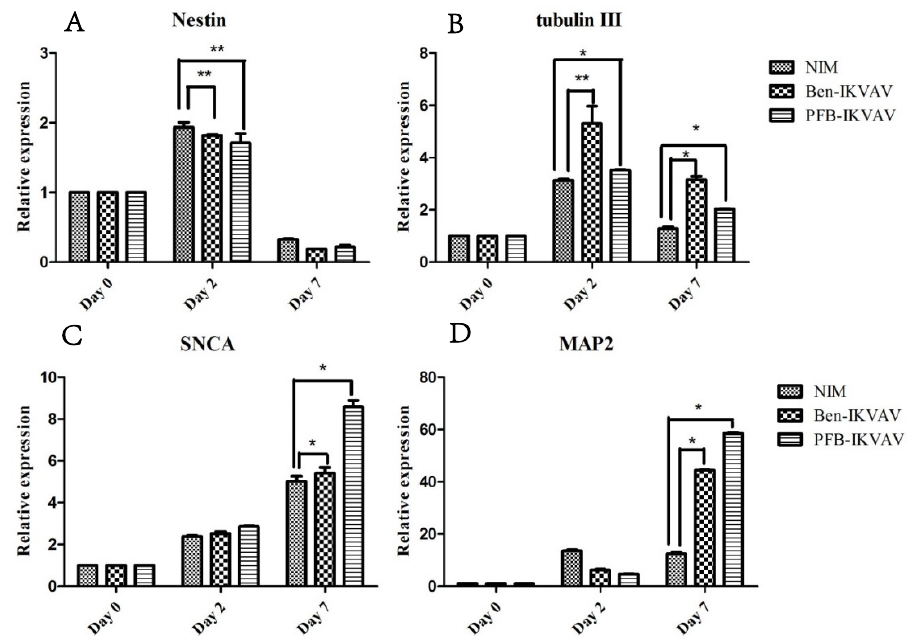
Figure 9. RT-qPCR analysis of neuronal-specific markers ( A ) Nestin, ( B ) β -tubulin, ( C ) SNCA, and ( D ) MAP2 of hMSCs cultured with NIM (control), NIM in the presence of Ben-IKVAV, and NIM in the presence of PFB-IKVAV for 2 days and 7 days (*: p < 0.05, ** : p < 0.01).